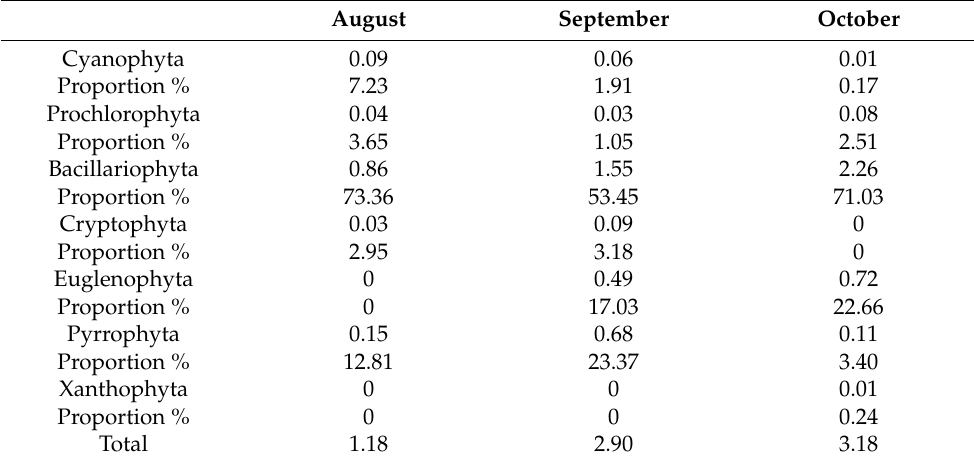
Table 9. Biomasses (mg/L) and proportions of phytoplankton attached to artificial